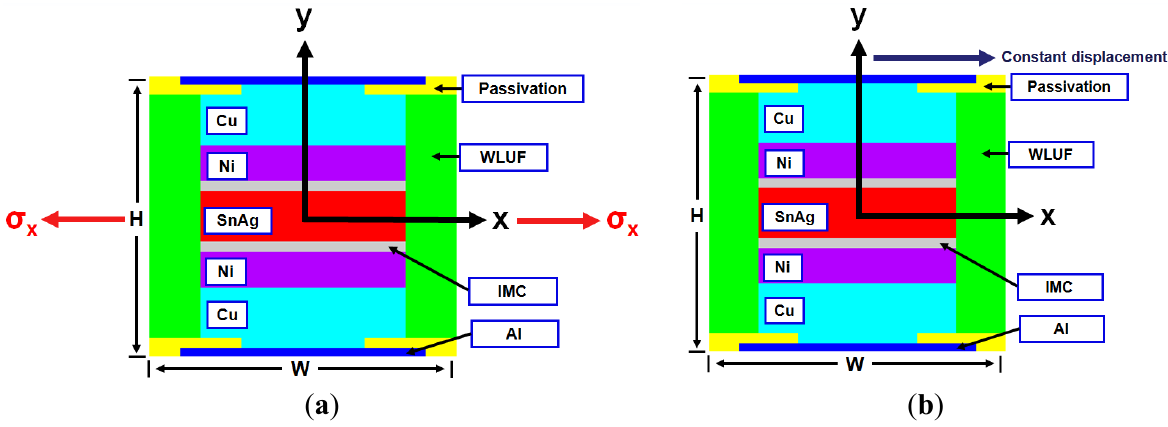
Figure 2. FEA model of microbump unit for the extraction of equivalent material properties: ( a ) Young’s modulus; ( b ) shear modulus.